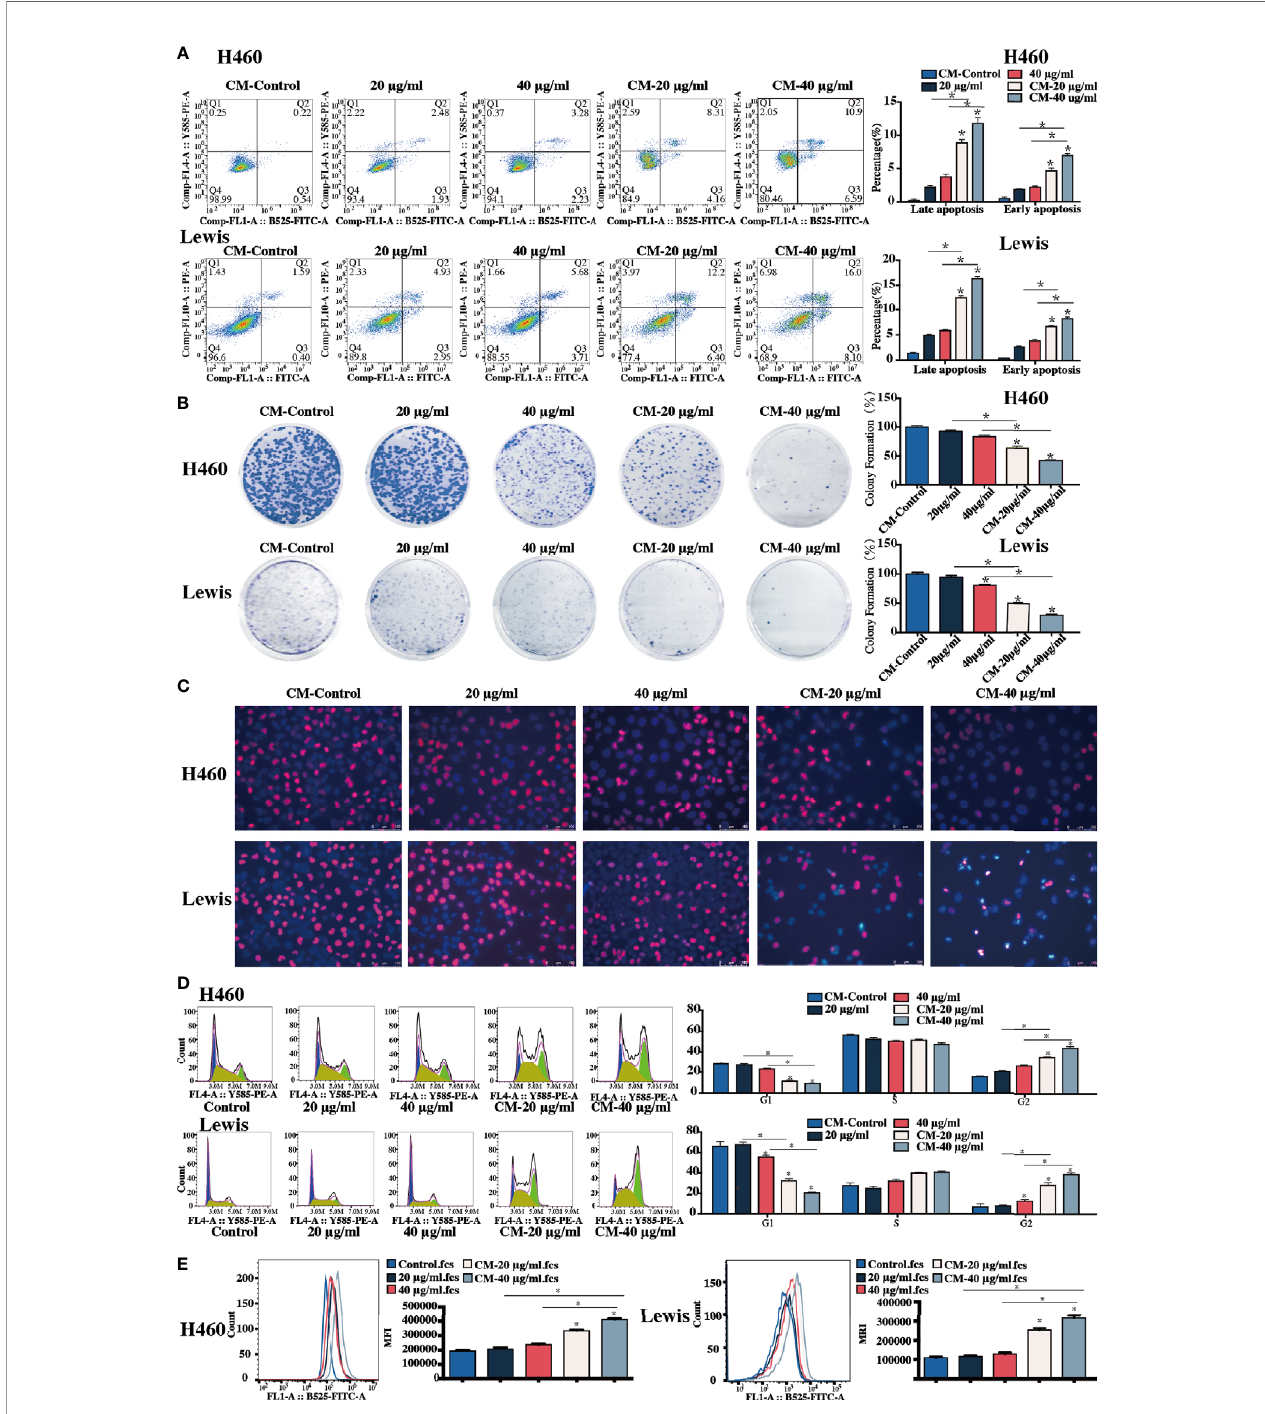
FIGURE 4 | Sophoridine-stimulated macrophage-lung cancer cell crosstalk induced cell apoptosis, cell colony formation, and suppressed cell proliferation. (A) The cell apoptosis of H460 with or without in fi ltration of sophoridine-stimulated THP-1-derived macrophages, and Lewis lung cancer cells with or without sophoridine- stimulated RAW264.7 macrophages determine by fl ow cytometry analysis. (B) The cell colony formation of H460 with or without in fi ltration of sophoridine-stimulated THP-1-derived macrophages, and Lewis lung cancer cells with or without sophoridine-stimulated RAW264.7 macrophages. (C) The cell proliferation and apoptosis of H460 with or without in fi ltration of sophoridine-stimulated THP-1-derived macrophages, and Lewis lung cancer cells with or without sophoridine-stimulated RAW264.7 macrophages determine by EdU and Hoechst staining. (D) The percentage of cell number in the G1, S, and G2/M phase during the cell cycle of H460 with or without in fi ltration of sophoridine-stimulated THP-1-derived macrophages, and Lewis lung cancer cells with or without sophoridine-stimulated RAW264.7 macrophages detect by fl ow cytometry using PI staining. (E) ROS intensity with or without in fi ltration of sophoridine-stimulated macrophages (n = 3), p < 0.05